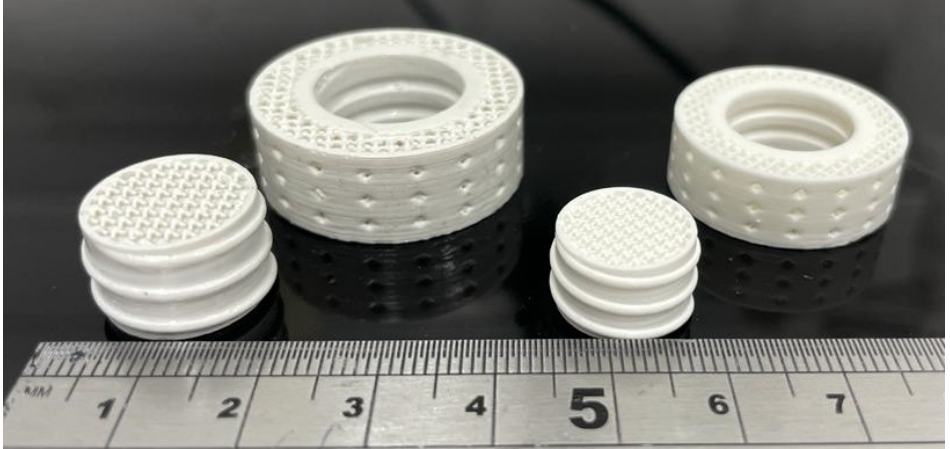
Figure 7. Green parts (left) and sintered parts (right).